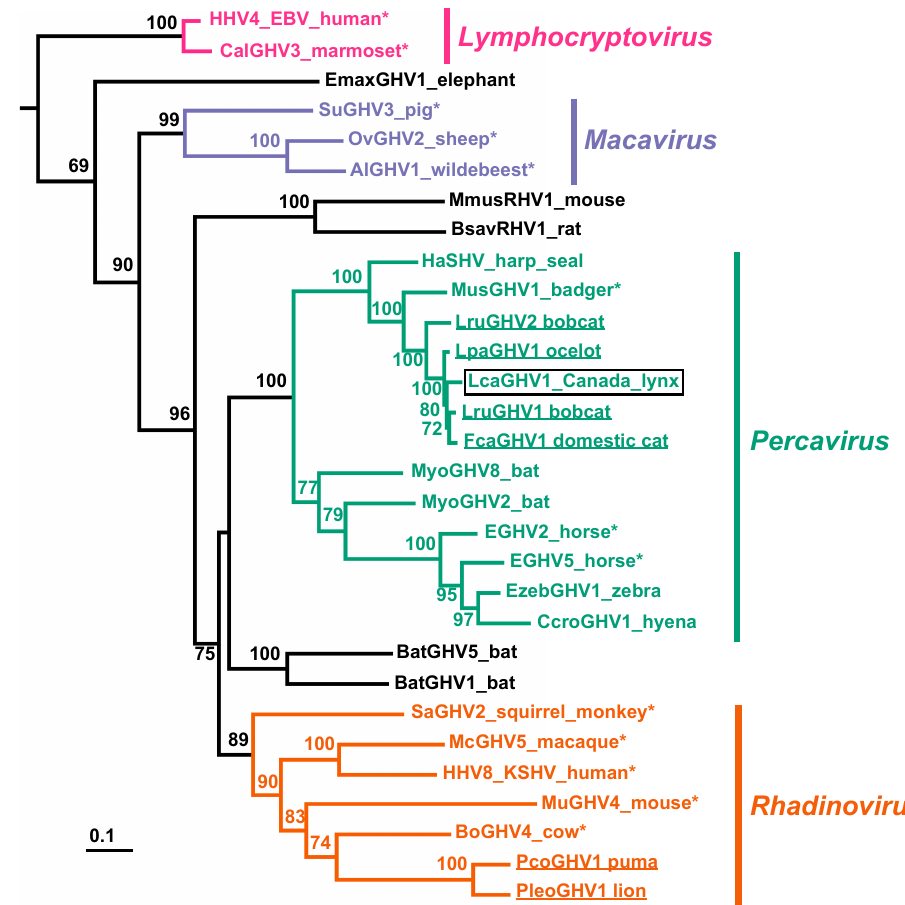
Figure 4. Phylogenetic analysis of various GHVs using concatenated gB and DNApol amino acid alignments. The betaherpesvirus human cytomegalovirus (human herpesvirus 5; GenBank accession no. NC006273)wasusedtorootthetree. Bootstrapanalyseswereperformedwith100iterations, andsupport for each node is displayed (values less than 60 are not shown). Scale bar indicates genetic divergence (amino acid substitutions per site). The 4 GHV genera are labelled and were determined using the last common ancestor of accepted members of each genus (indicated with an asterisk), per the International Committee on Taxonomy of Viruses (ICTV) 2017. LcaGHV1, identified in this study, is identified with a black box. Felid-hosted GHVs are underlined. Virus abbreviations, definitions, and GenBank accession no. are as follows: HHV4, human herpesvirus 4 (Epstein–Barr virus (EBV)), NC007605;